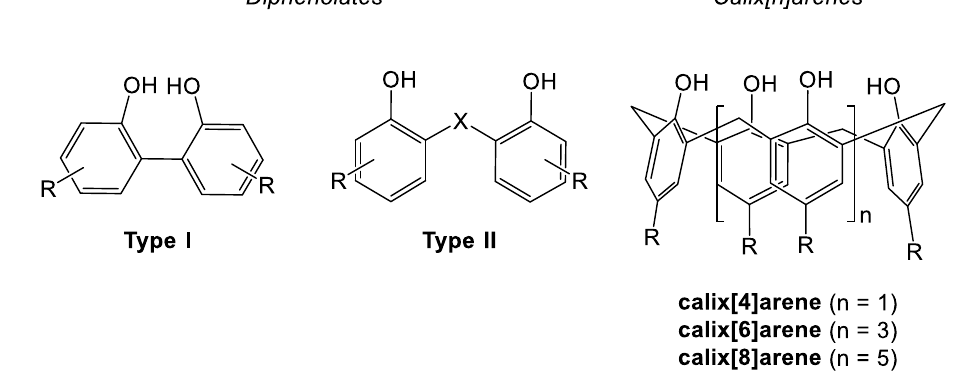
Figure 1. Phenol-based pro-ligands [1–5].